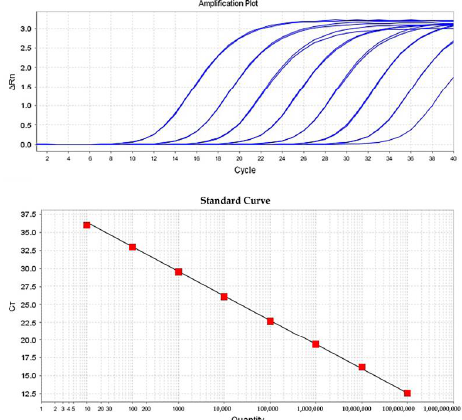
Figure 2. Amplification plot and standard curve of real-time RT-qPCR prepared with 10-fold serial dilutions of in vitro-synthesized RNA transcripts (ToBRFV PV-1236 isolate nucleotide 1482-6393) using real-time RT-qPCR with the primer and probe set ToBRFV-2703-s/ToBRFV-2838-as/ToBRFV-2760 L. Upper graph: amplification curves of a dilution series. The amplification data shown are from triplicate measurements of a 10-fold dilution series with 100,000,000 down to 10 copies per reaction by plotting ∆Rn against cycle. ∆Rn is calculated at each cycle: ∆Rn (cycle) = R n (cycle) — baseline, where Rn = normalized reporter. Lower graph: standard curves were generated by linear regression analysis, plotting the Ct value in the Y-axis versus the logarithm of the starting RNA dilutions in the X-axis. Each plotted point represents the mean Ct value that was calculated from the three replicates.